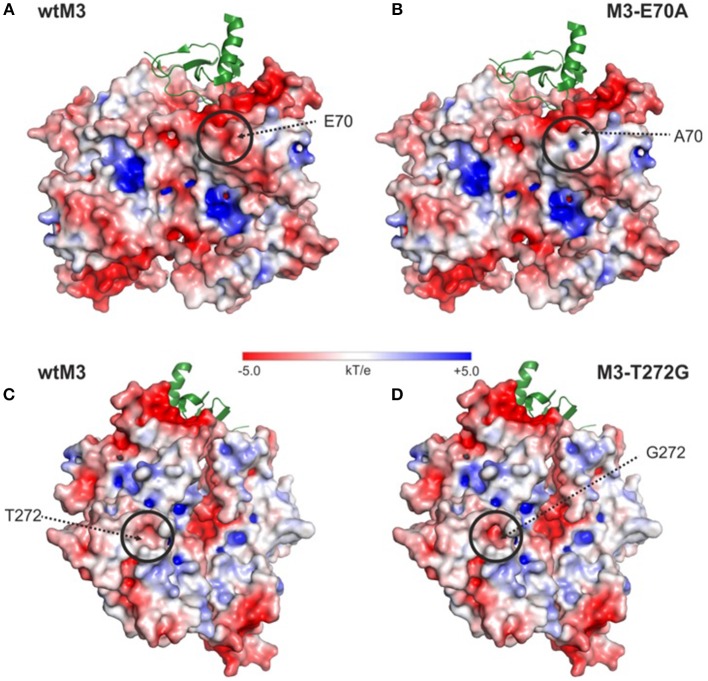
Surface electrostatic charge distribution of wtM3 and modeled M3-E70A and M3-T272G mutants. (A,C) Electrostatic charge distribution calculated for the surface of wtM3. (B,D) Surface electrostatic charge distribution for the E70A-M3 and T272G-M3 mutants. Areas with a change in charge distribution between the given M3 mutant and the wild-type protein are circled. The interacting chemokine in one of the two chemokine binding sites is shown as a green ribbon. The electrostatic surfaces of all M3's are shown (range ±5 kT/e). The surface was prepared using APBS (Zhou et al., 2000) and displayed using PyMOL.